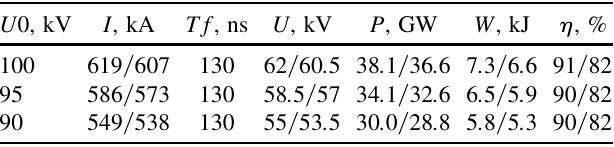
TABLE I. Pulse parameters depending on charging